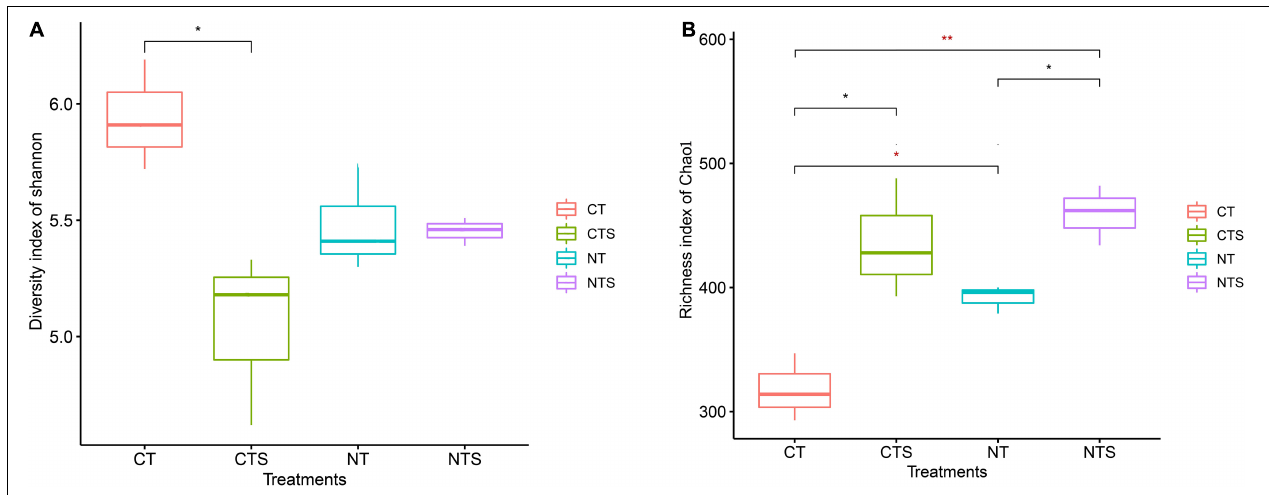
FIGURE 1 | Fungal alpha diversity associated with different soil treatments. The indices of diversity and richness are shown as Shannon (A) and Chao1 (B) , respectively. Statistically significant differences between different treatments were determined by T -test ANOVA ( p < 0.05). The symbols *, ** are used to show statistical significance at the 0.05, 0.01 level,